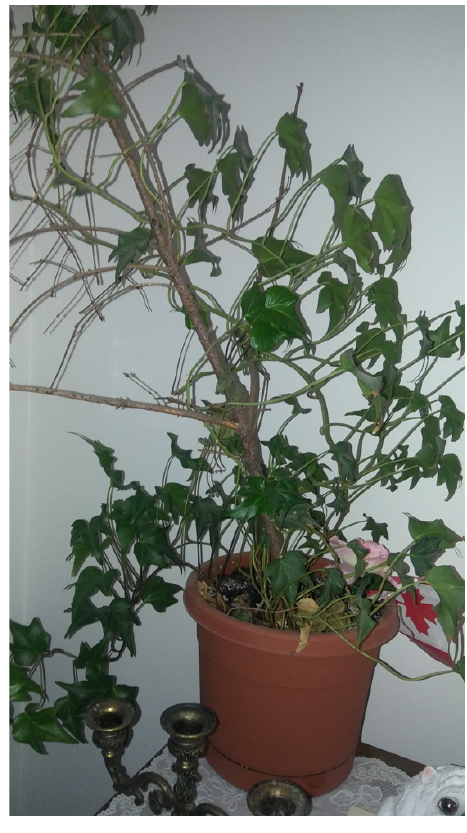
Image 5. Tee’s photograph: